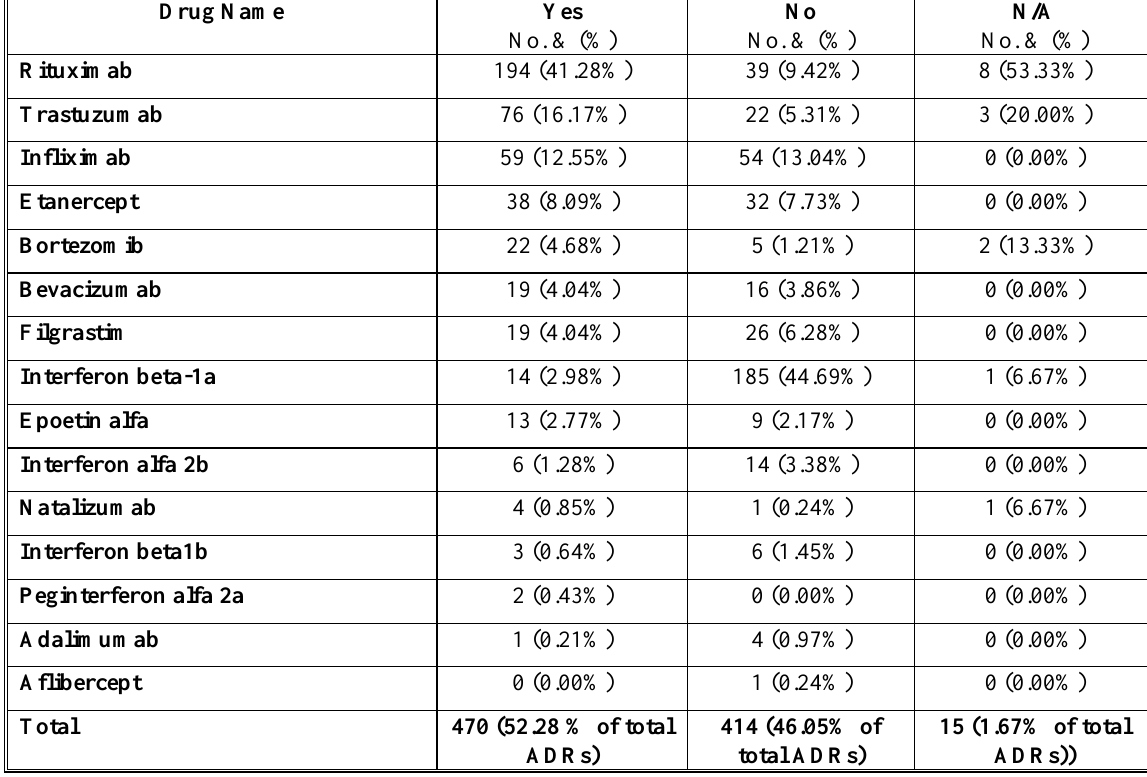
Table 9. Seriousness of the